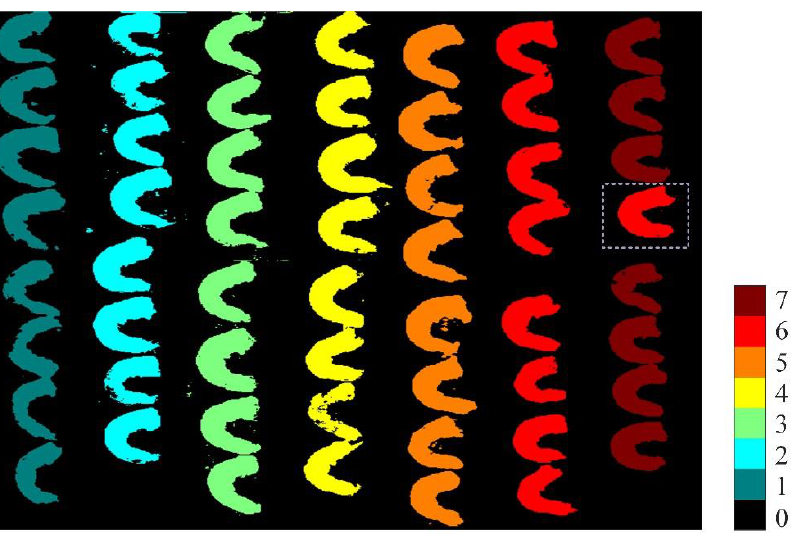
Figure 9. Visualization of White Shrimp on Different Refrigeration Days.